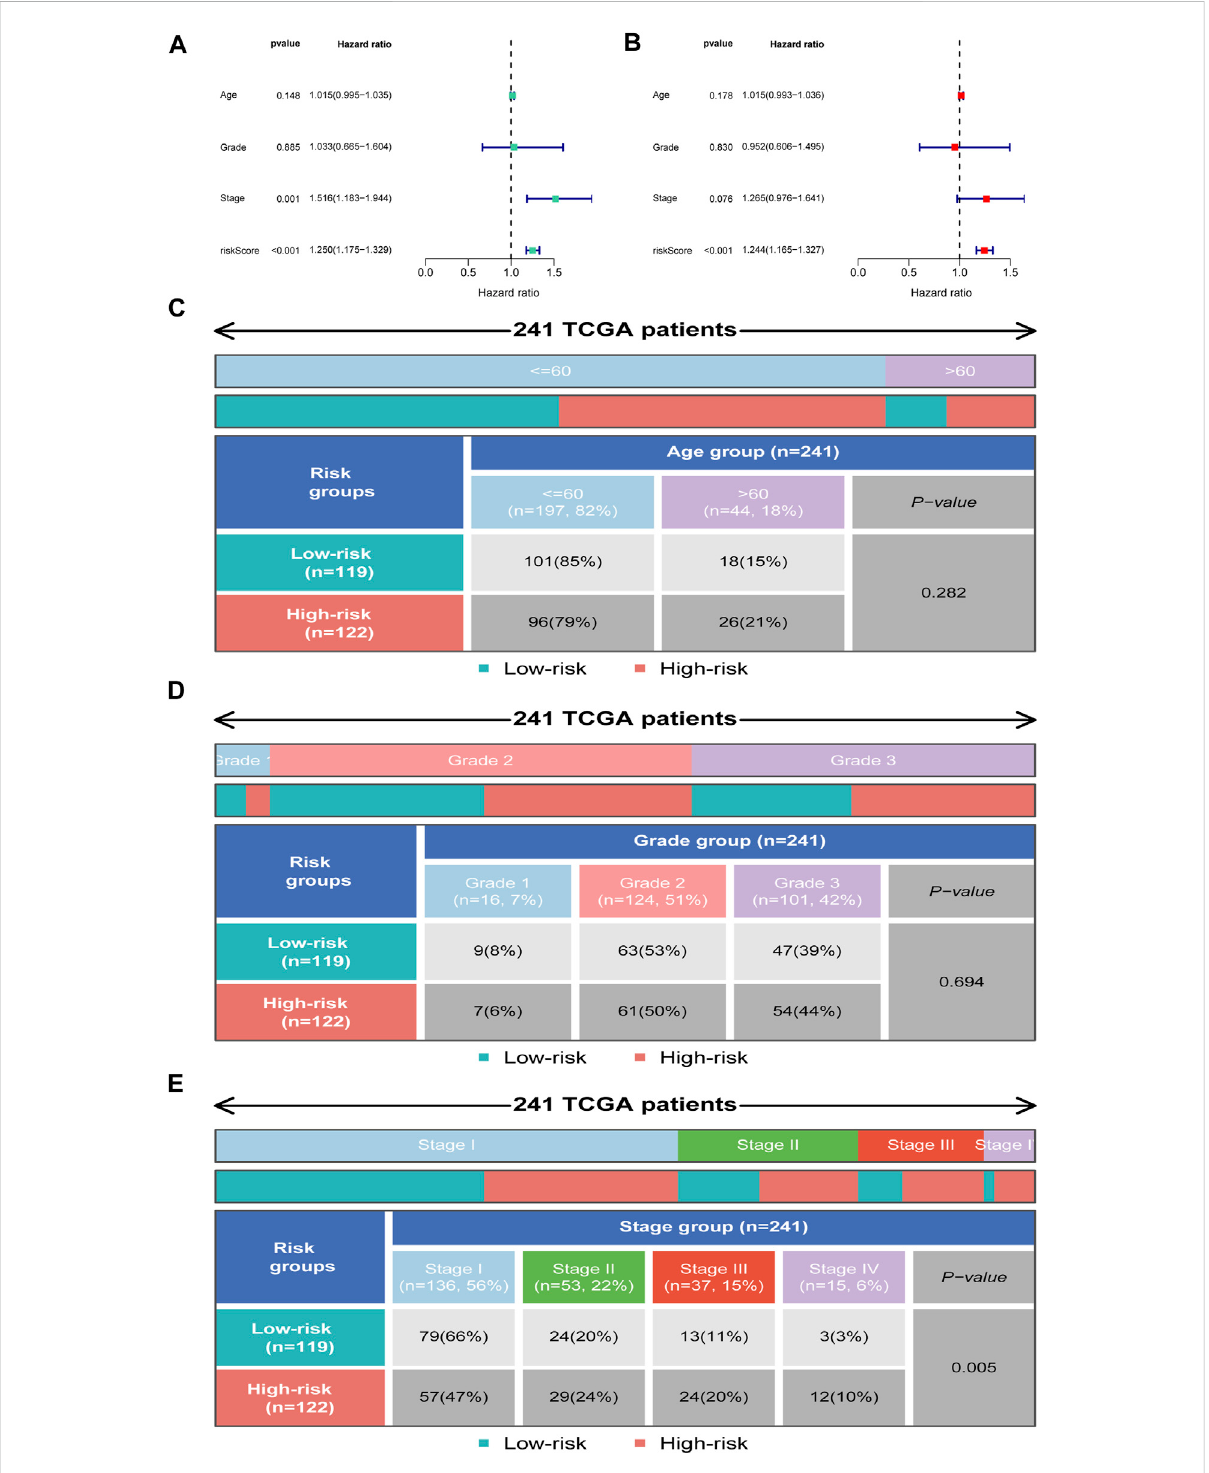
FIGURE 6 Independent prognosis analysis. (A) Univariate Cox regression analysis. (B) Multivariate Cox regression analysis. (C – E) Distribution of clinical subgroups in two risk